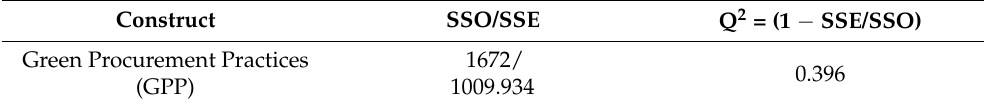
Table 8. Predictive relevance (Q 2 ).